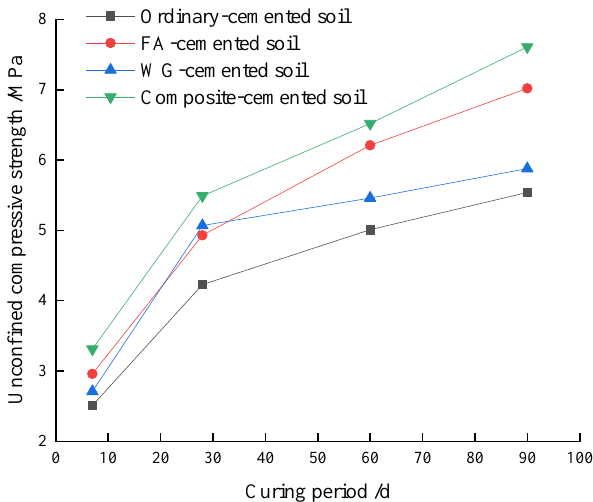
Figure 4. Changes of the UCS of the four types of cemented soil with the curing period.